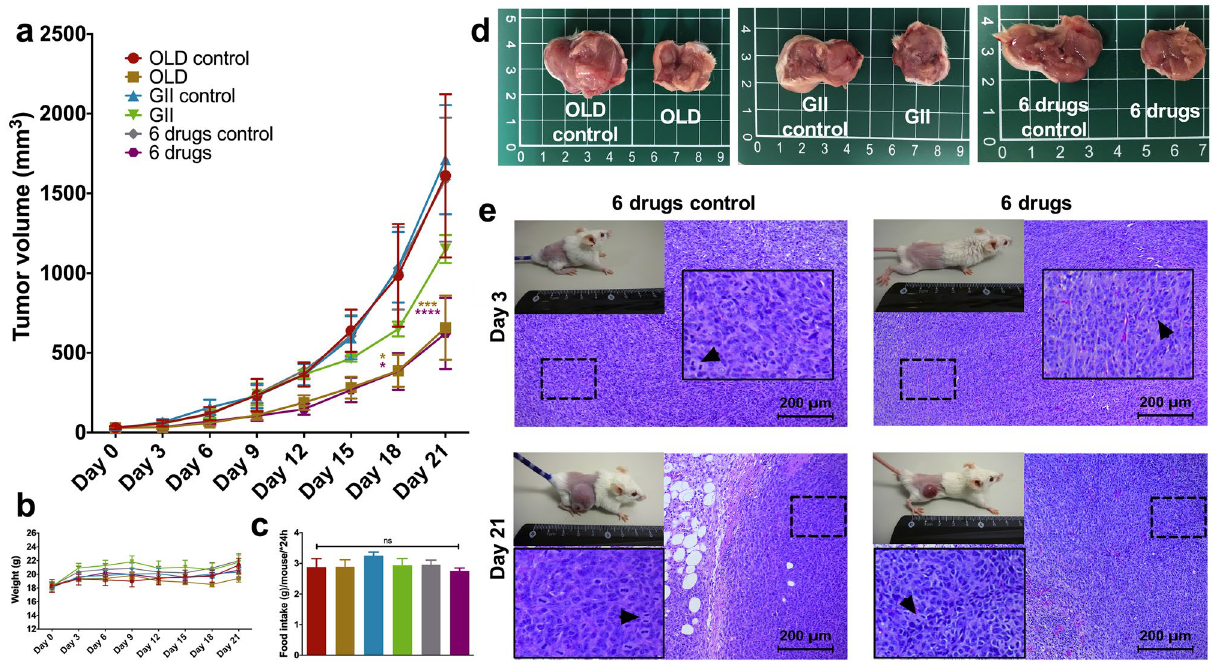
Figure 4. Tumor-bearing mice treated with the metabolic schemes have smaller tumor sizes. ( a ) 21-day time lapse of tumor volume with the OLD, GII, or 6 drugs combinations, or with their controls. ( b ) Weight changes over time. ( c ) Average food intake per mouse per 24 h. ( d ) Recovered tumor at day 21 of treatment. ( e ) Photography of mice at days 3 and 21 of treatment, and their respective H&E staining of isolated tumor samples, from the 6 drugs scheme. H&E Images are presented at 10X magnification, and a higher magnification shows with arrows examples of mitotic cells. Each condition was compared against its control. The images are representative of the data obtained. Data are expressed as means ± s.e.m. N = 3 independent experiments, 8 mice/ group. Statistical analyses were performed with two-way ANOVA with Tukey correction. Scale bars = 200 μm. OLD: Orlistat + lonidamine + DON; GII: Growth hormone + insulin + indomethacin; 6 drugs: OLD + GII; ns: non- significant; *p < 0.05 ; ***p < 0.001 ; ****p < 0.0001